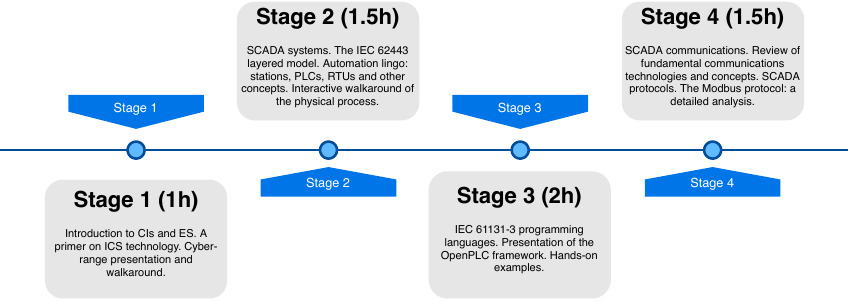
Figure 9. Organization of the first training module (6